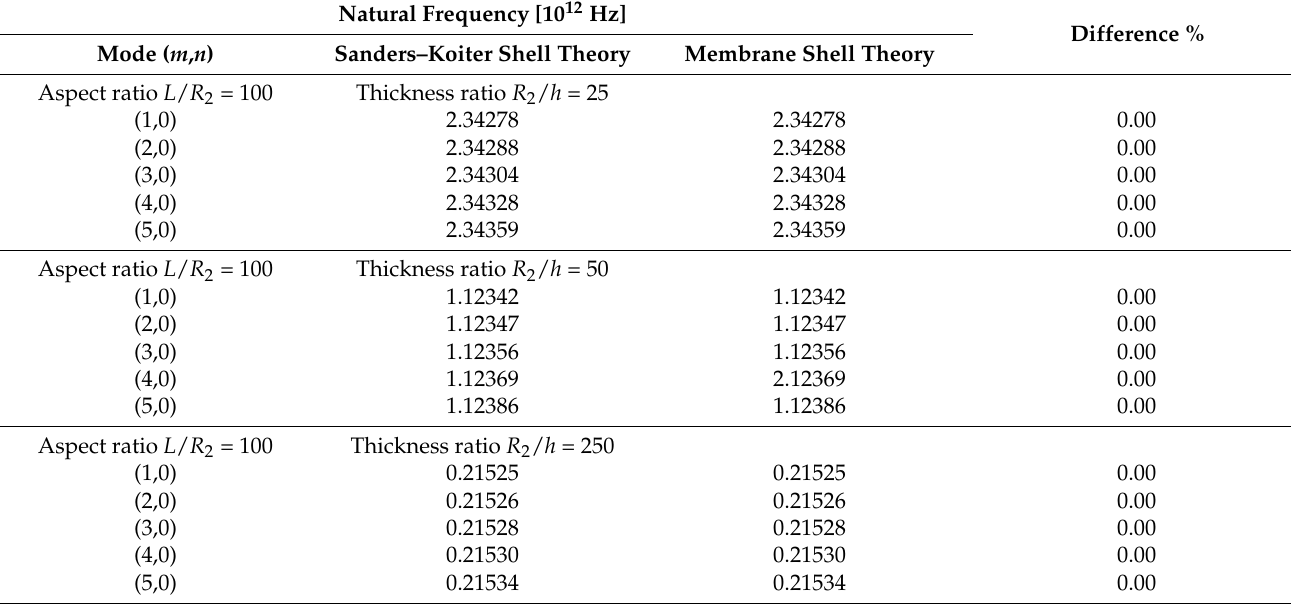
Table 5. Simply supported DWCNT with aspect ratio L / R 2 = 100 and thickness ratios R 2 / h = (25,50,250). Axisymmetric modes ( n = 0). Comparisons between Sanders–Koiter and membrane shell